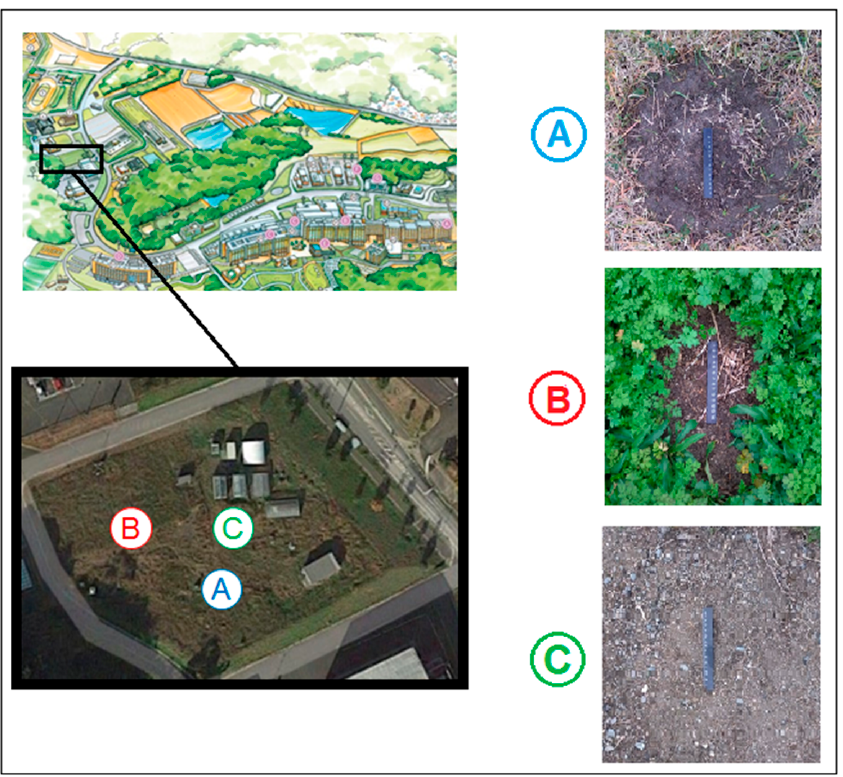
Figure 1. Map of the INAS test field study area with three different measuring locations, A, B, and C, located at Ito campus, Kyushu University, Japan. Because specific soil characteristics could influence results, the following three locations within the INAS test field were selected for our study: Location A: covered with leaf litter and several clusters of living grasses. Location B: soft soil surface covered with living grasses. Location C: hard soil with many pebbles and no grass or leaf